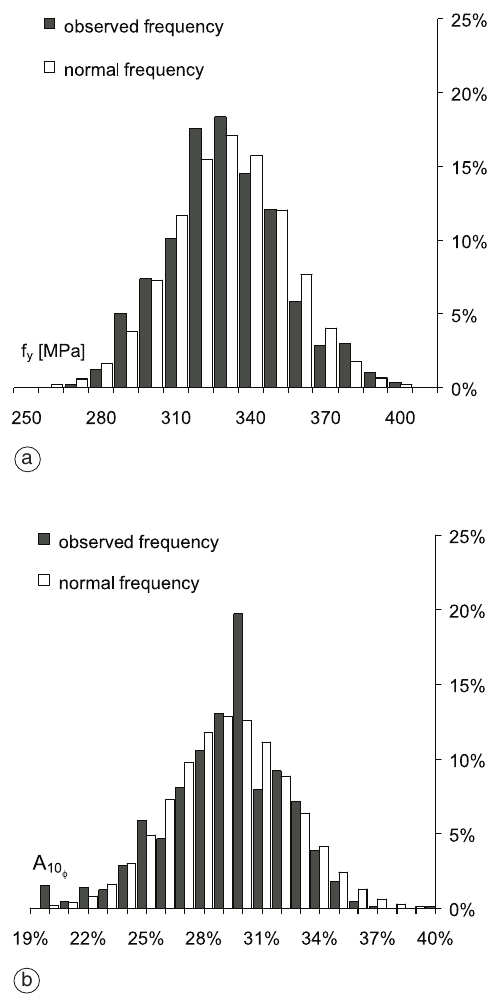
Table III. Mechanical properties of steel Aq. 42 in the year 1960. Analyzed data: